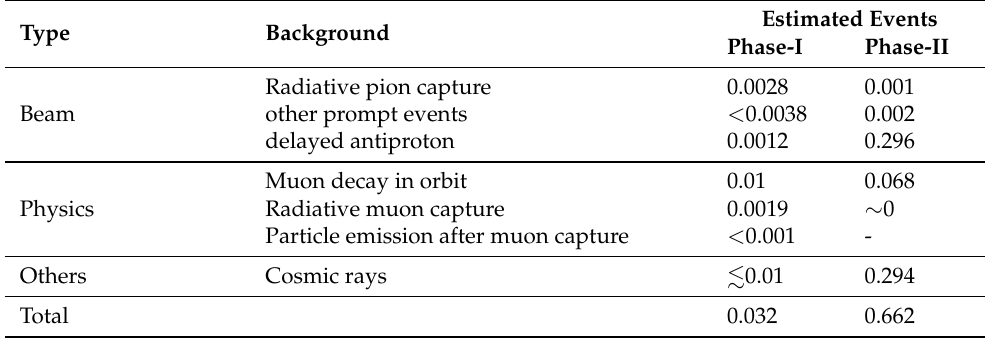
Table 2. Summary of estimated background events for the COMET experiment